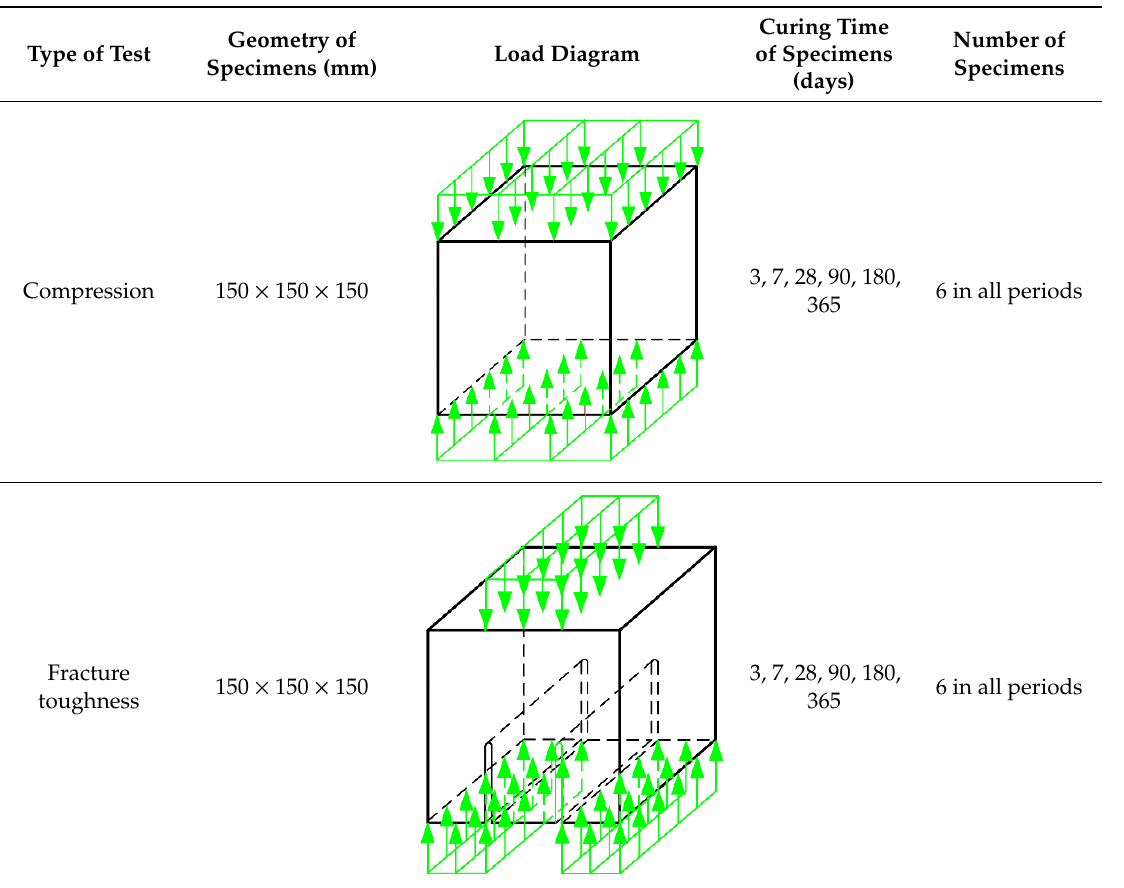
Table 5. Experimental program.